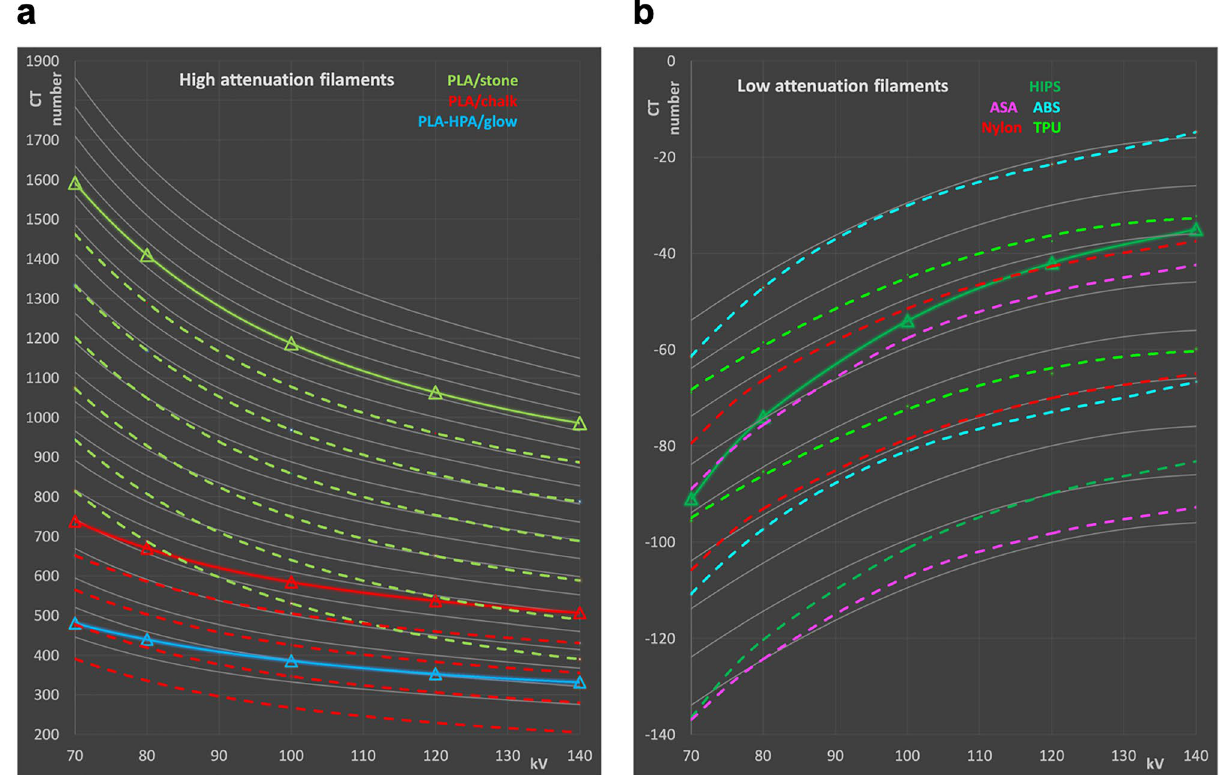
Figure 4. Calculated CT numbers of samples with reduced density (broken lines) compared to bone ( a ) and adipose tissue ( b ) in the HU ranges of interest. ( a ) PLA/stone measured and with reduced density in 5% steps from 95 to 70%; PLA/chalk: measured CT values, and 95–80%, and measured values for PLA/glow. ( b ) HIPS (100%: measured values, and 95%), ASA (95%, 90%), ABS (95%, 90%), Nylon (87.5% and 85%), and TPU (87.5 and 85%),